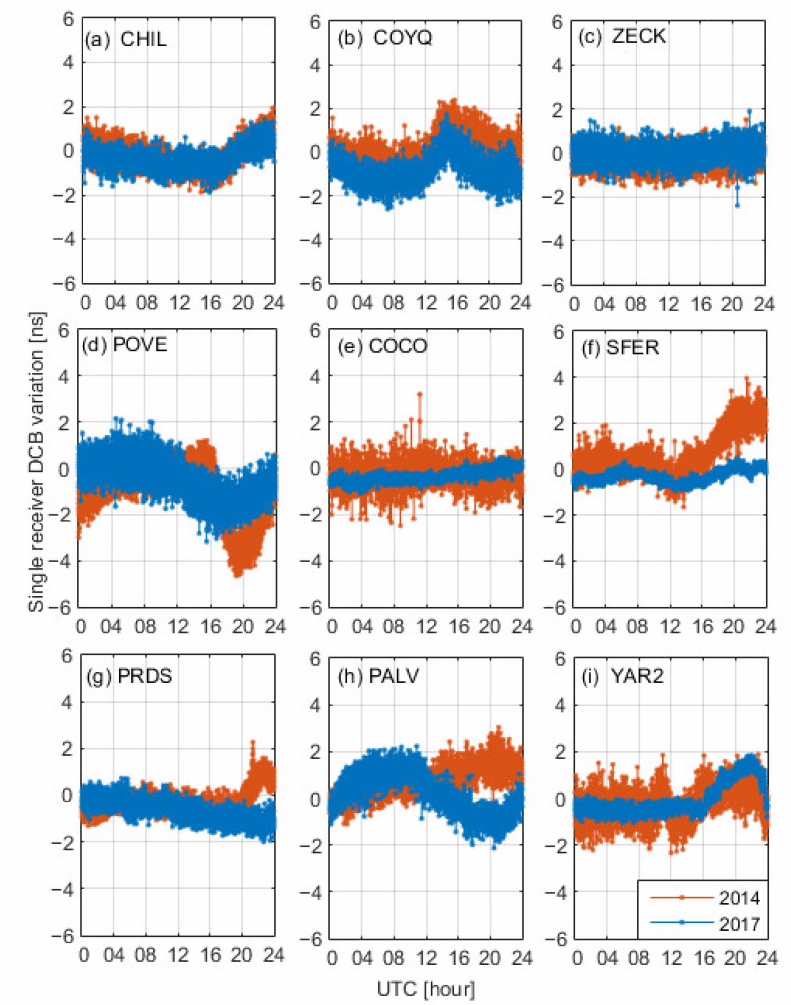
Figure 9. Intraday variations in the receiver DCBs estimates obtained using MCCL for the analyzed stations over one day (DOY 06) in 2014 (red lines) and 2017 (blue lines). The lines are shifted to the same datum for ease of